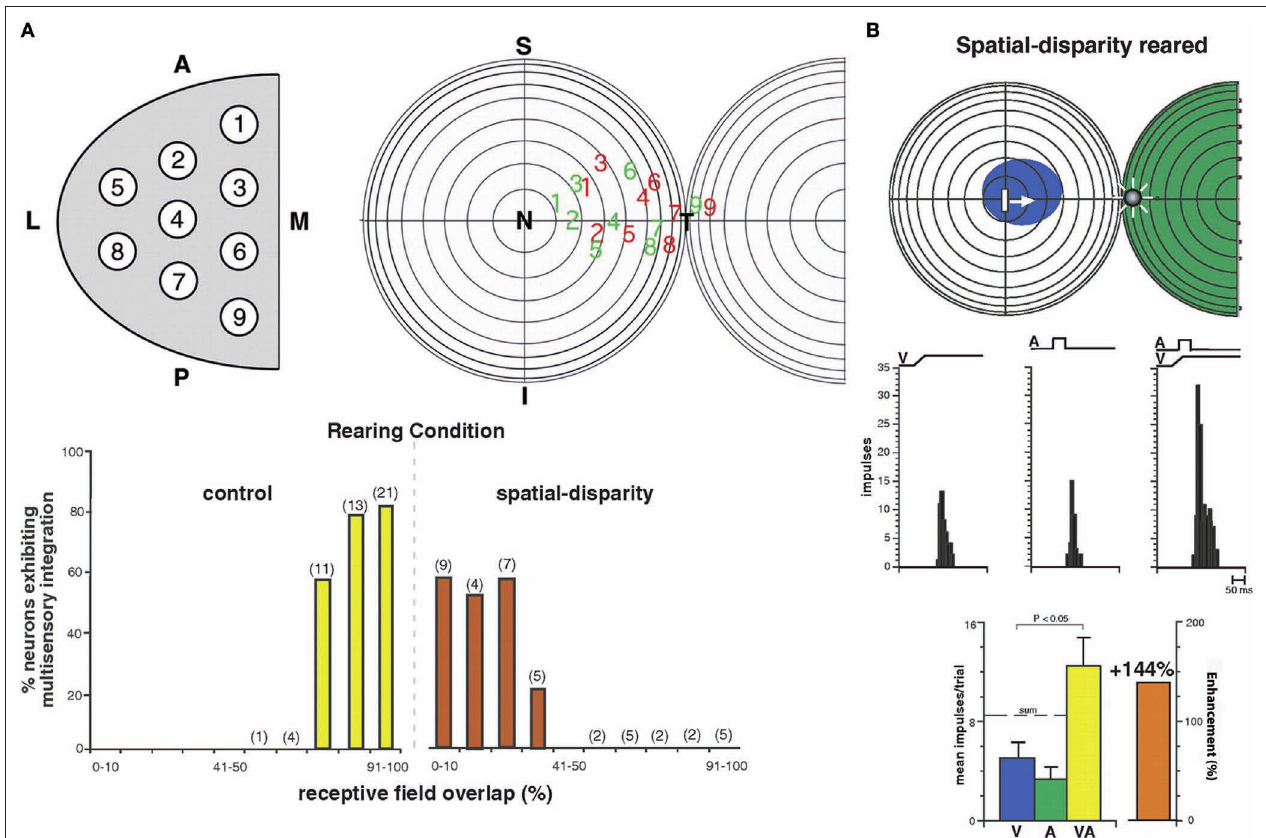
FIGURE 4 | Animals reared with spatially disparate visual and auditory stimuli develop atypical receptive fi elds and multisensory integration. (A) Receptive fi eld overlap in neurons from normal and spatial disparity reared animals. Top : A sampling of all SC quadrants (left) yielded visual (red) and auditory (green) receptive fi elds whose center distributions are shown (right). Bottom : % receptive fi eld overlap in control animals (yellow) was often 91–100%; far exceeding that seen in animals reared with spatially disparate visual and auditory stimuli (red, often < 10%). (B) An example of the non-overlapping receptive fi elds